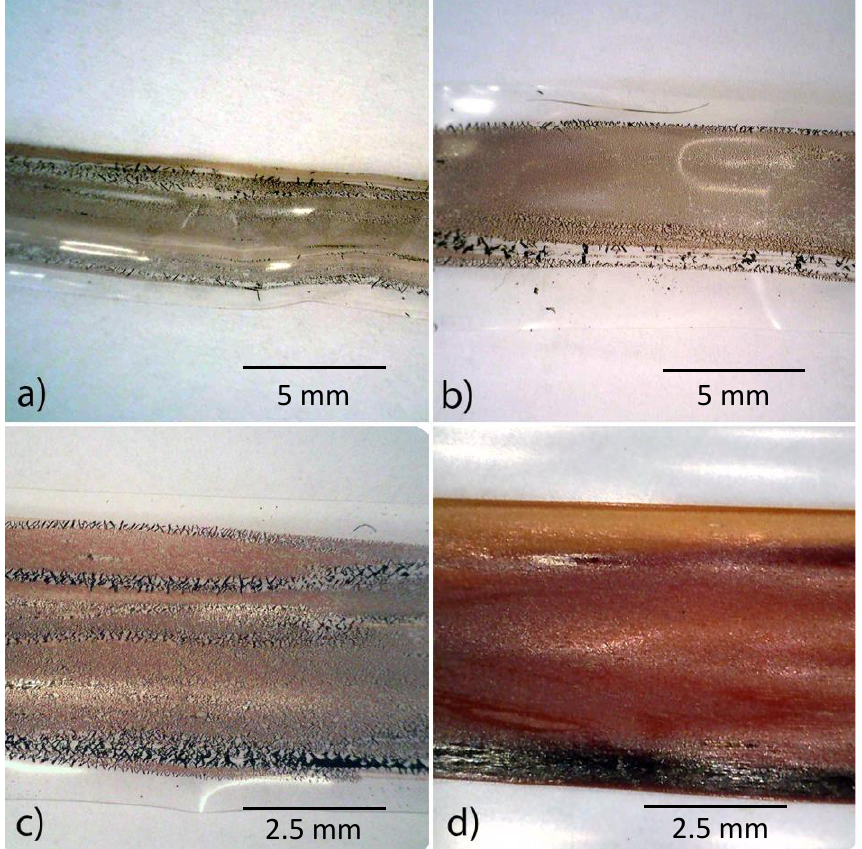
Figure 10. Stretched samples at higher magnification, ( a ) PEDOT- g -PAU 30, ( b ) PEDOT- g -PAU 50, ( c ) PEDOT- g -PAU 100; ( d ) PEDOT- g -PAU 150.